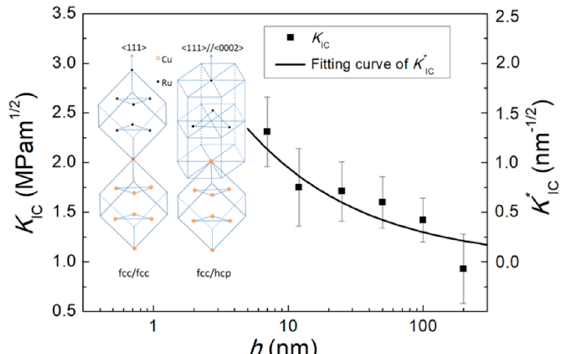
Figure 16. Dependence of K IC on h (dots and left y-axis) for the Cu/Ru multilayers. Calculated normalized K IC (lines and right y-axis) based on Equation (20) fits well with experimental results. Sketch shows the lattice structures transformation from the fcc/hcp to fcc/fcc epitaxial relationship, which determines the fracture toughness at small length scale [15].